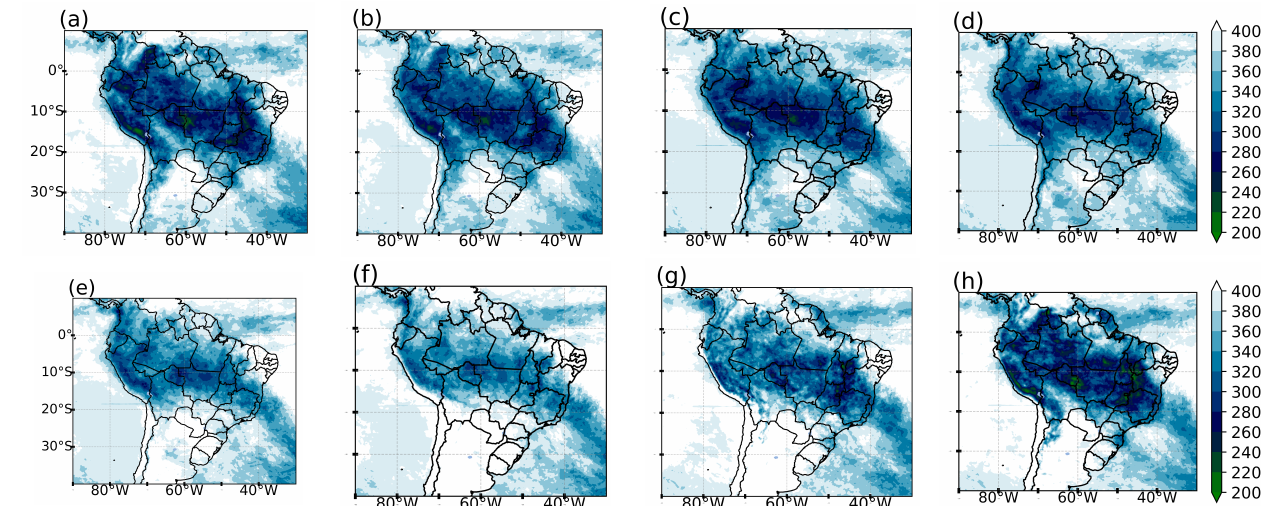
Figure 9. Composites of the diurnal spatial cycle of the OLR to ( a ) 00 UTC, ( b ) 03 UTC, ( c ) 06 UTC, ( d ) 09 UTC, ( e ) 12 UTC, ( f ) 15 UTC, ( g ) 18UTC, and ( h ) 21UTC of the SACZ events during the unfavorable phase of the MJO. Figure 10a–h, depicting the diurnal cycle of the OLR for the MJO transition